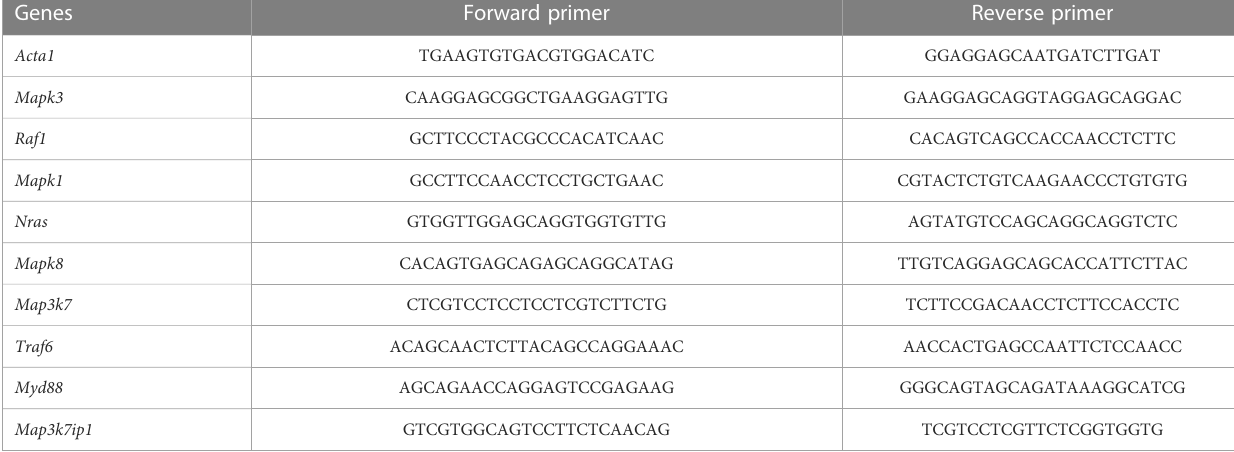
TABLE 1 Sequences of the primers used for a reverse transcription-quantitative polymerase chain reaction.